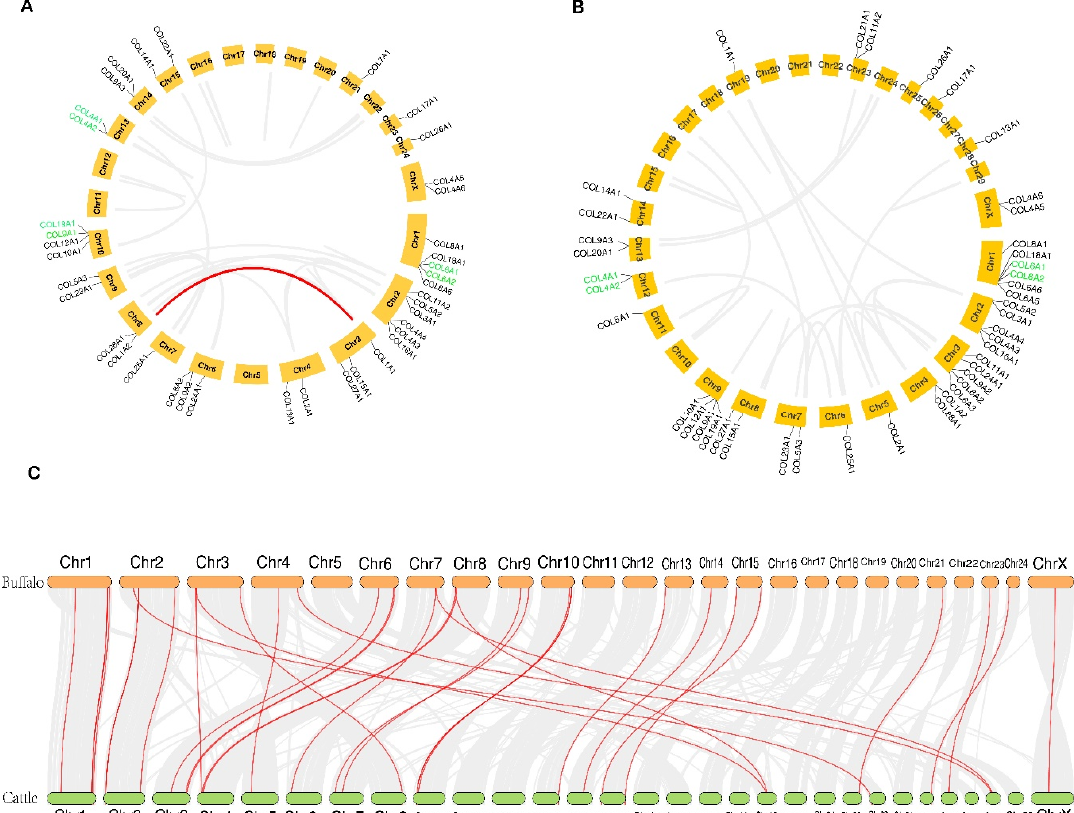
Figure 3. Gene duplication of buffalo ( A ) and cattle ( B ) collagen genes, as well as their collinear analysis ( C ). The tandem duplicated genes were marked by the green color, and segmentally duplicated genes are indicated by the red line.